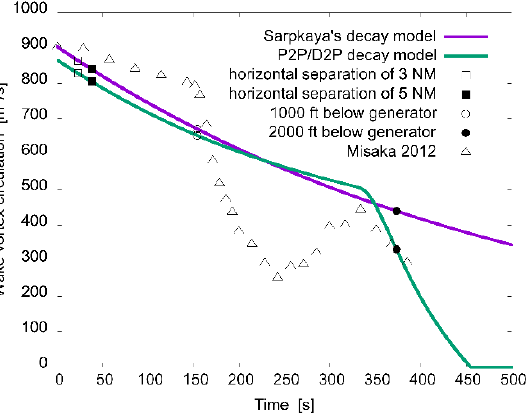
Figure 6. Wake vortex circulation Γ vs. time t from Sarpkaya’s [26] and P2P/D2P [31] decay models, and data for ε ∗ = 0.01 and N ∗ = 0.00, taken from [24], for A380-861 aircraft.